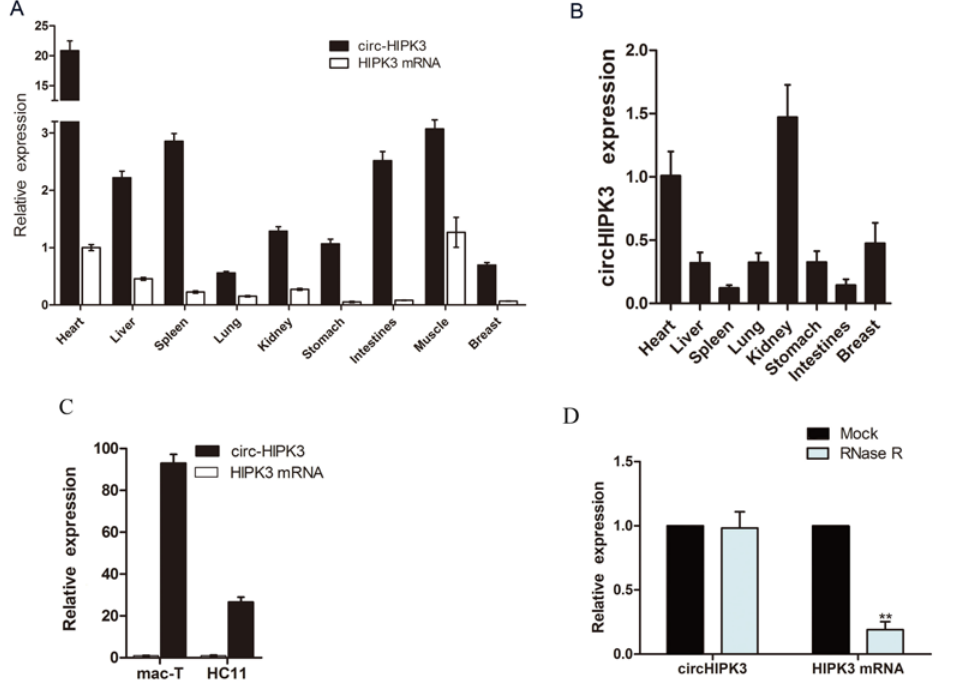
Figure 2. The circHIPK3 is widely expressed. ( A ) The expression profile of circHIPK3 and HIPK3 mRNA in cattle tissues; ( B ) The expression profile of circHIPK3 and HIPK3 mRNA in mouse tissues; the mean ± SEM of tissues from six cow or mouse samples; ( C ) The expression profile of circHIPK3 and HIPK3 mRNA in MAC-T cells and mouse mammary epithelial cell lines (HC11 cells). The mean ± SEM of three samples and three independent experiments; ( D ) The expression of circHIPK3 and HIPK3 mRNA after treatment with RNase R. Mean ± SEM of three samples from three independent experiments. * p < 0.05; ** p < 0.01.